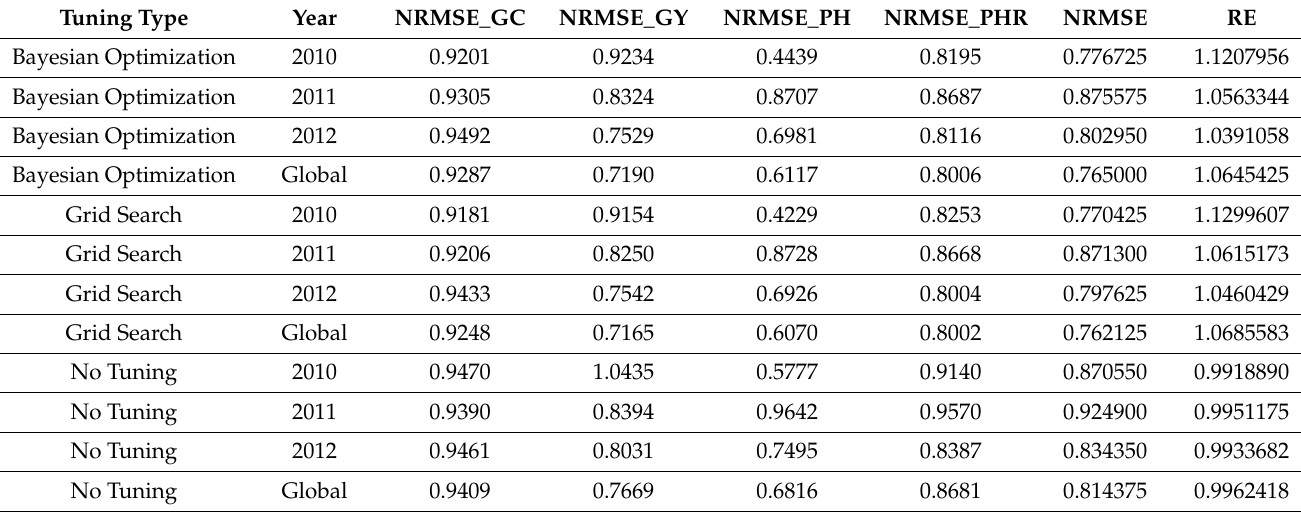
Table A2. The prediction performance for every environment and across environments (Global) of the dataset 2 (Indica) in terms of normalized root mean square error (NRMSE) under three methods (BO, GrS and NT) for the Indica dataset. RE denotes relative efficiency. The RE in rows corresponding to BO were computed dividing the NRMSE under NT by the NRMSE under BO. The RE in rows corresponding to GrS were computed dividing the NRMSE under NT by the NRMSE under GrS. Those RE in the rows corresponding to NT strategy were computed dividing the NRMSE under GrS by the NRMSE under